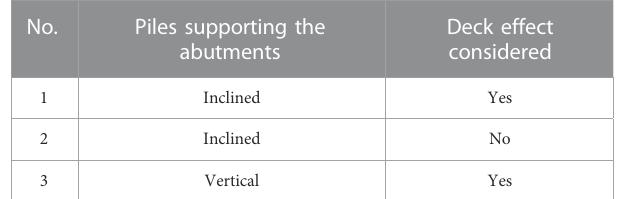
TABLE 5 The cases analyzed in this